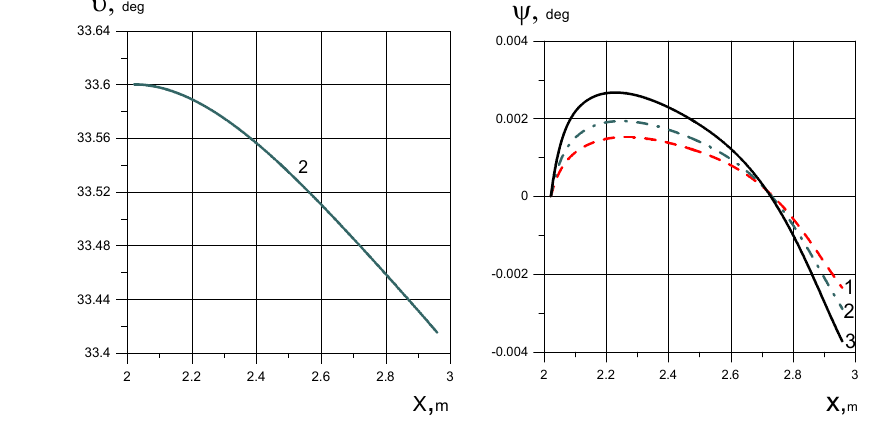
Figure 9 – Calculated values of the pitch angle υ and the yaw angle ψ of the axis of the projectile along the length x of the spatial movement at different elevation angles θ 0 of the Рис . 9 – Расчетные значения угла тангажа ν и угла рыскания ψ оси снаряда по длине участка x пространственного движения при различных углах θ